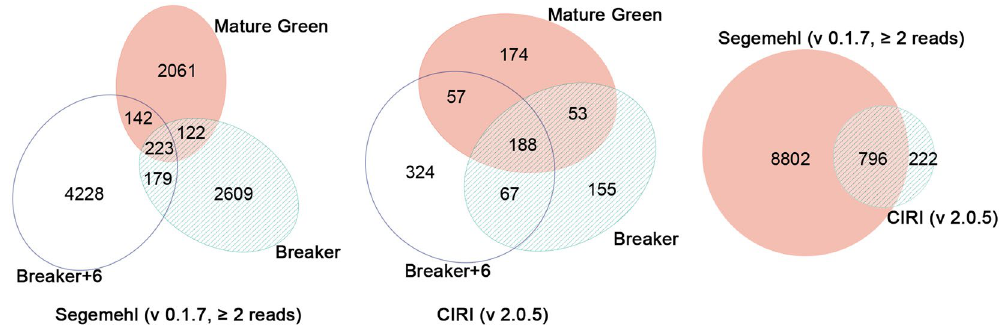
Figure 1. Distribution of circular RNAs among fruits at different ripening